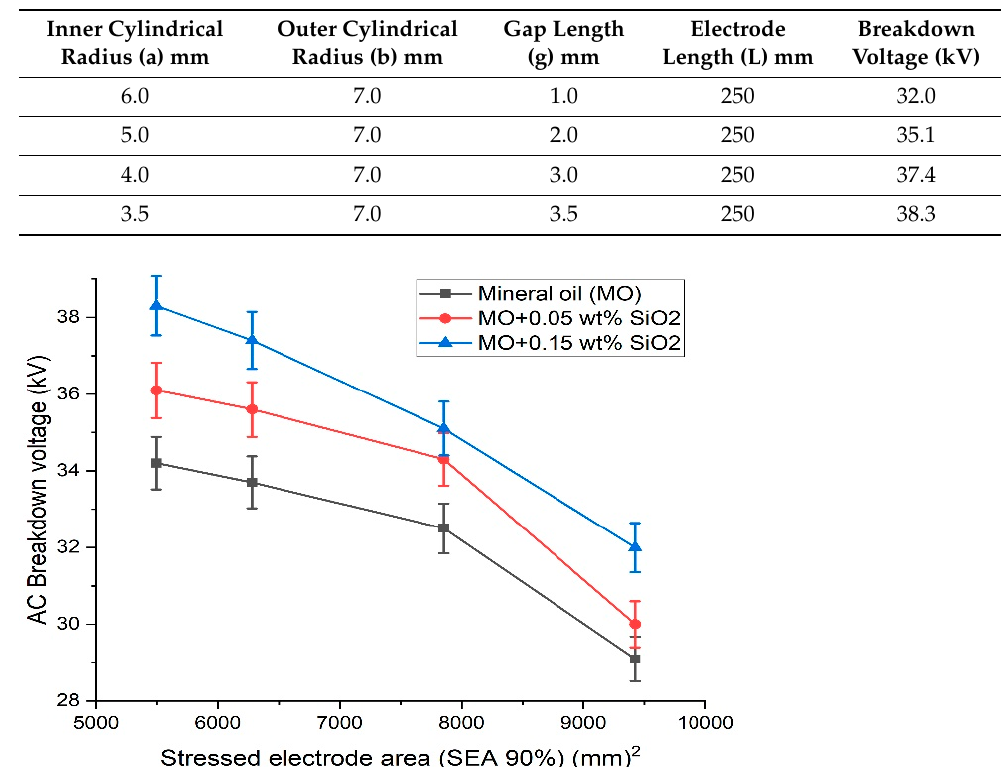
Table 6. Breakdown voltage of mineral oil with 0.15 wt% nanoparticle concentration.